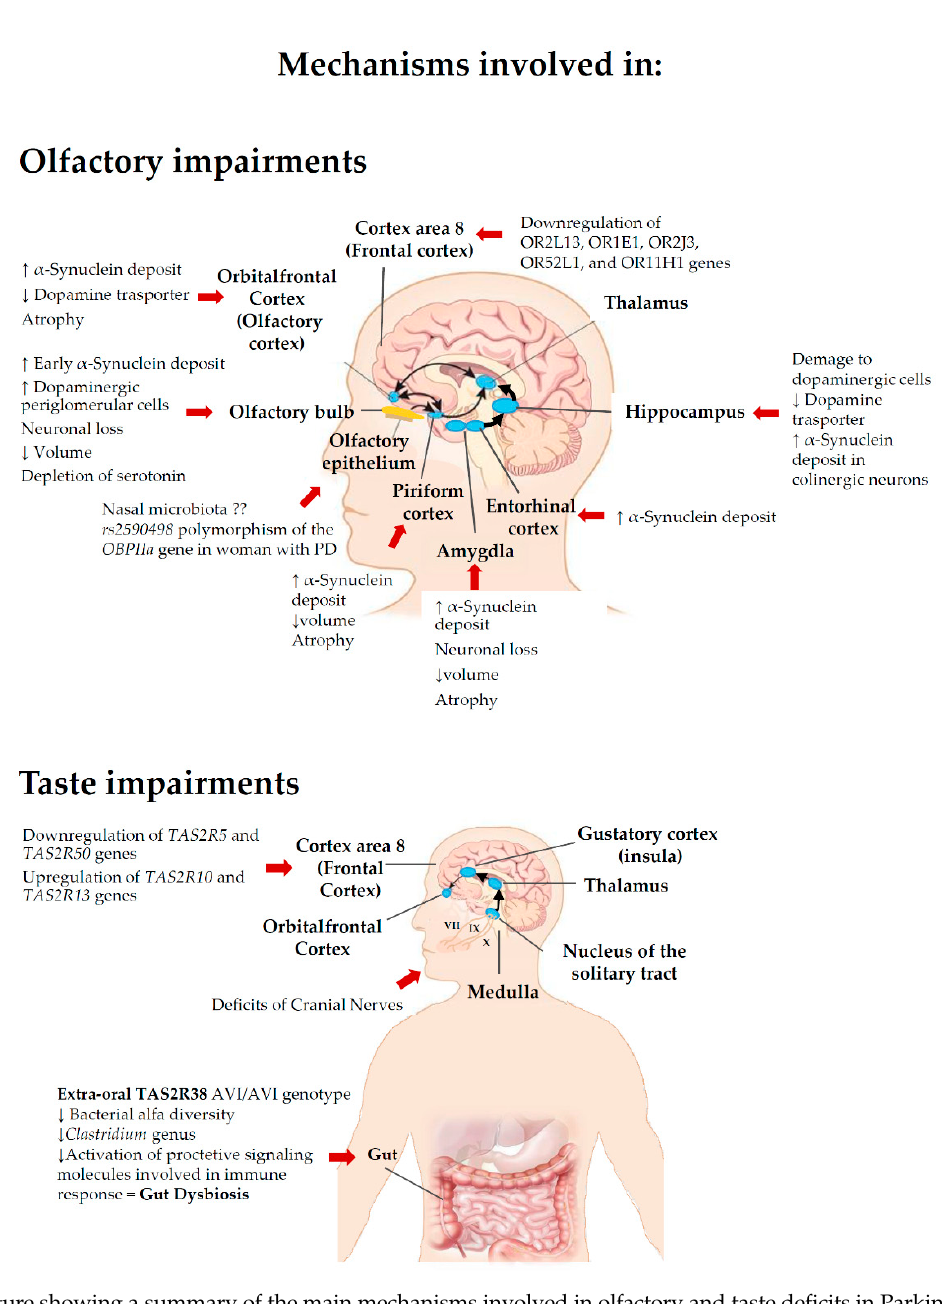
Figure 1. Picture showing a summary of the main mechanisms involved in olfactory and taste deficits in Parkinson’s